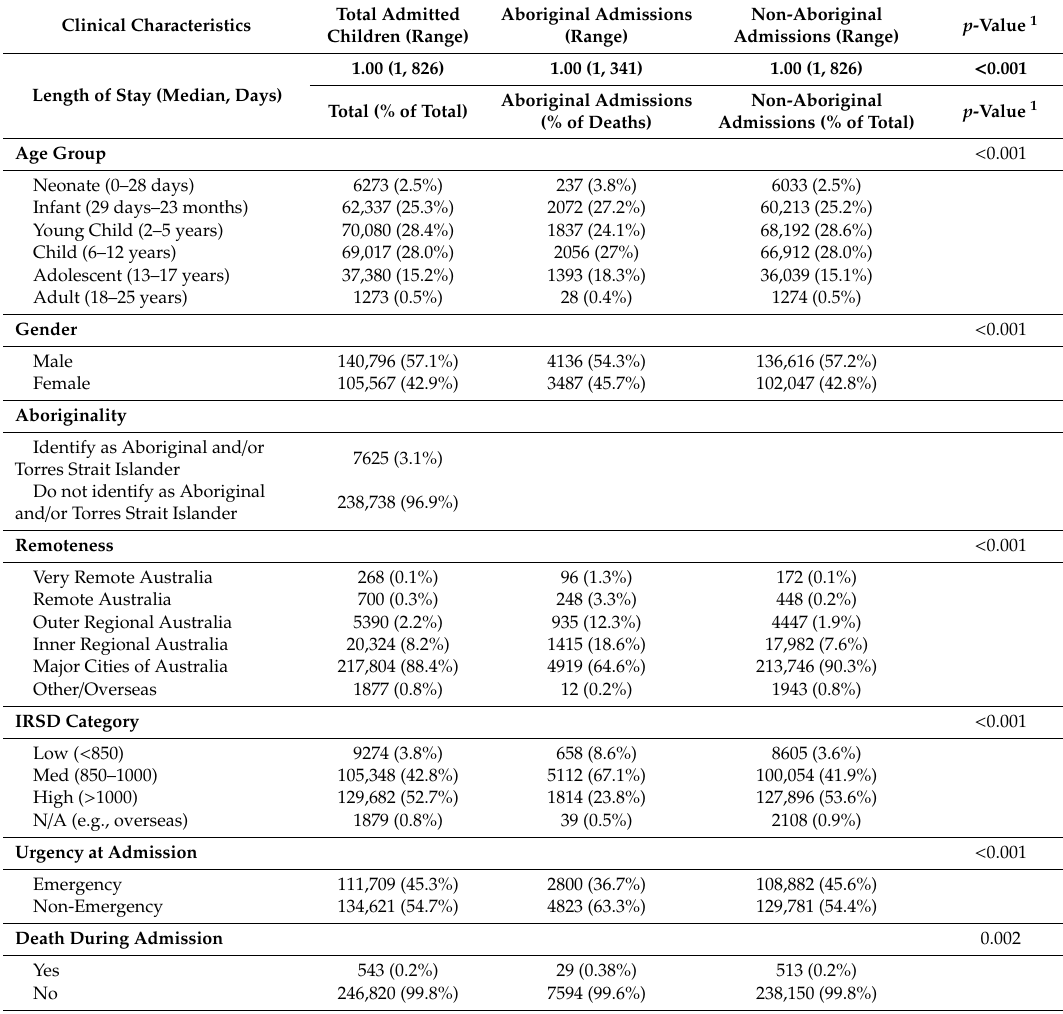
Table 1. Demographics and clinical characteristics of